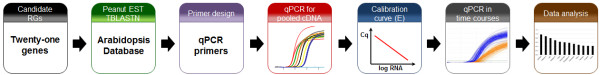
Scheme of experimental design. Twenty-one candidate reference genes were evaluated for qPCR in peanut hairy root. Peanut nucleotide sequences were obtained using homologous sequences from Arabidopsis. Then, primer design was performed using AlleleID 7 software. The set of primers for the 21 candidate reference genes were tested in a pool of samples from peanut hairy roots. PCR efficiency was calculated and used as first screening to select the genes to be analyzed in two time course experiments in peanut hairy roots. Data analysis was performed to determine the best reference gene and optimal number of reference genes to be used for normalization procedures.